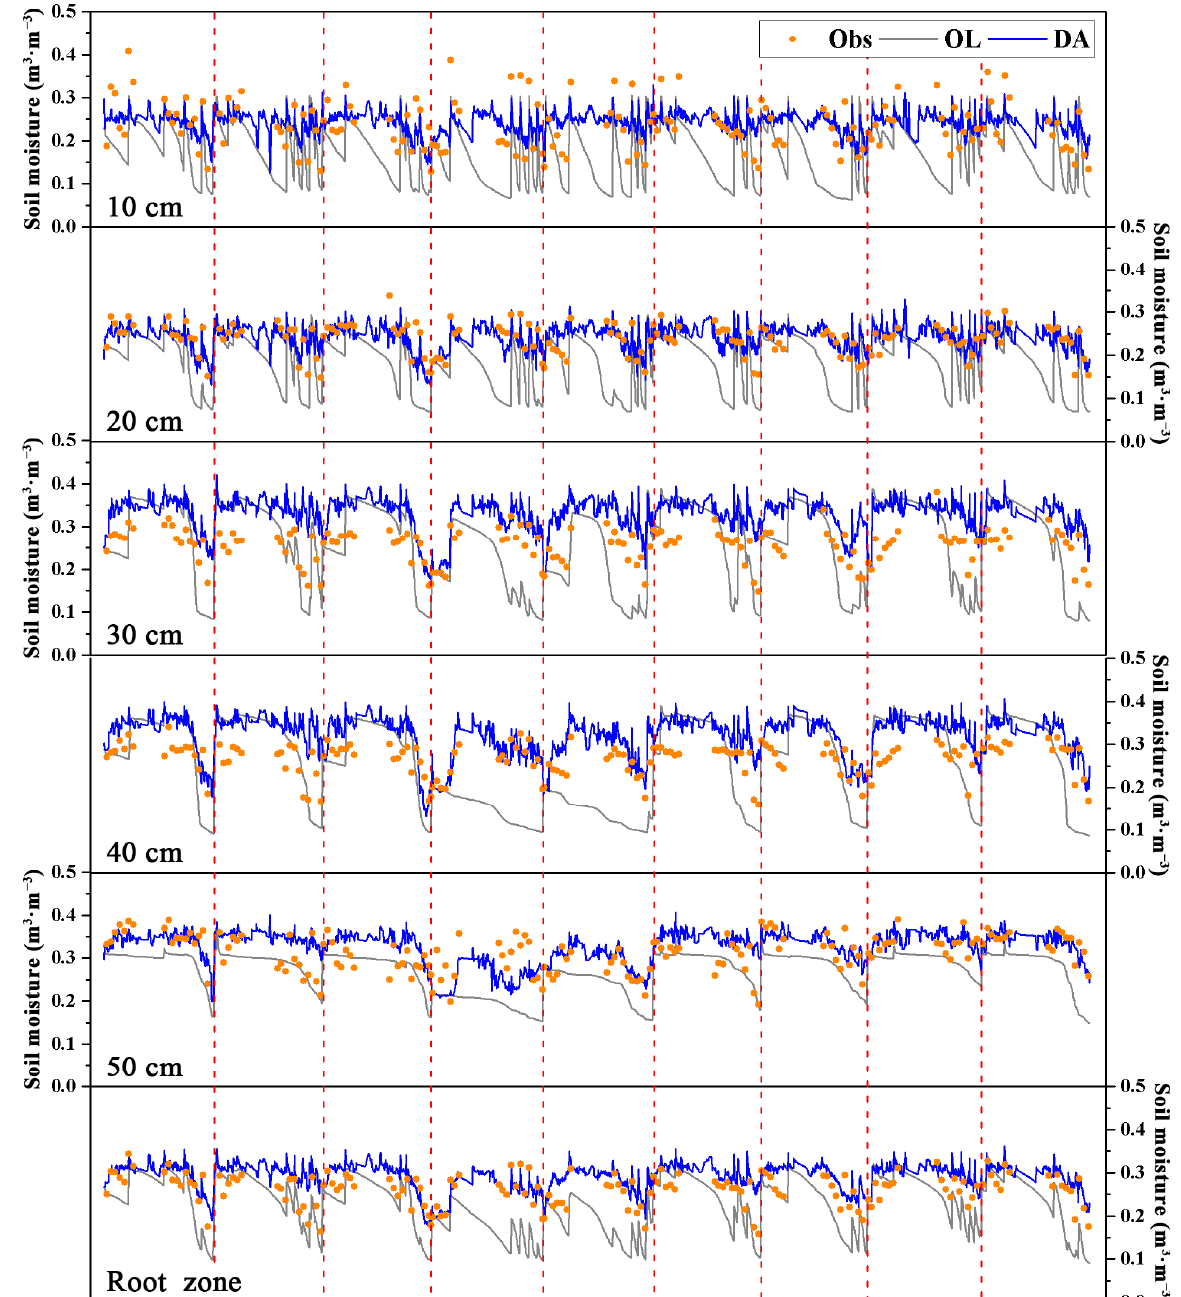
Figure 2. Comparison of open loop (OL) and assimilated (DA) soil moisture with observations (Obs) during the winter wheat growing seasons (2002–2011) at the HBBZ site.